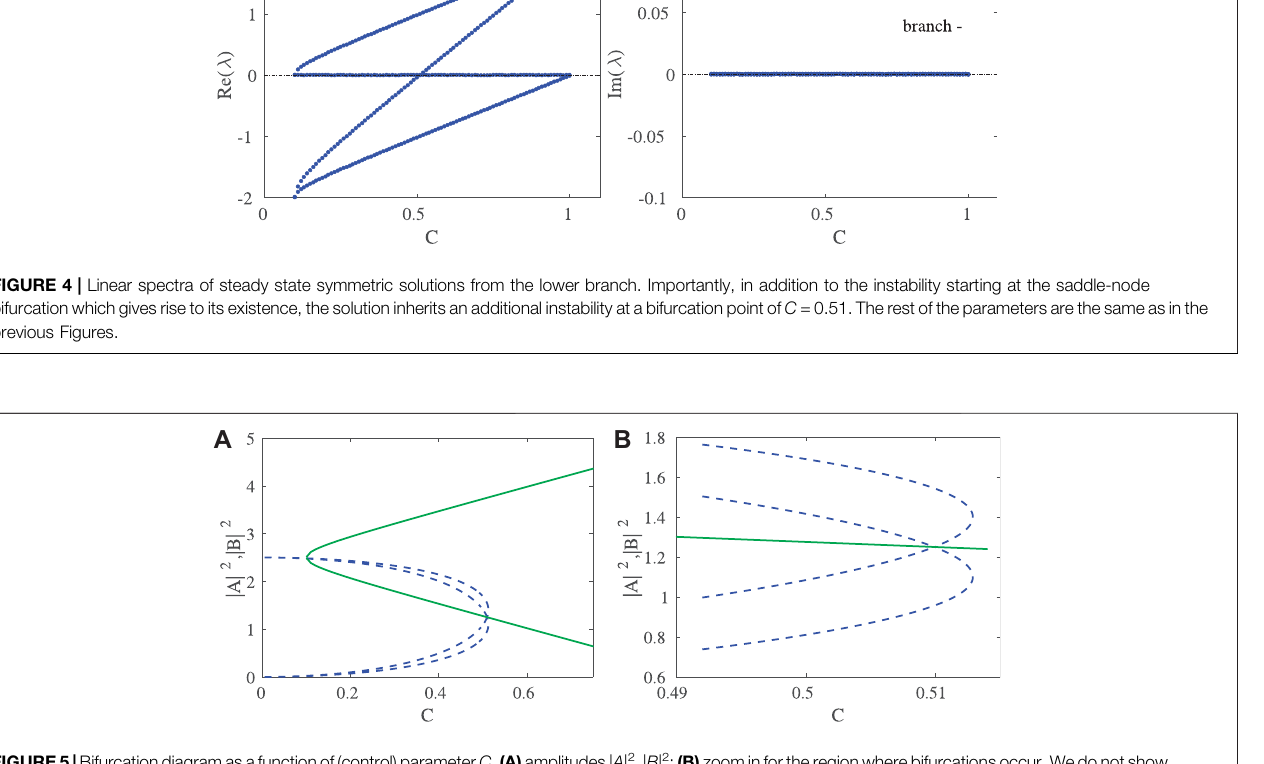
FIGURE5| Bifurcationdiagramasafunctionof(control)parameter C . (A) amplitudes| A | 2 ,| B | 2 ; (B) zoominfortheregionwherebifurcationsoccur.Wedonotshow here the results for ϕ and ξ , although the same bifurcation features can be observed therein. The solid (green) lines pertain to the symmetric branches of solutions, while the dashed (blue) ones to the asymmetric branches.